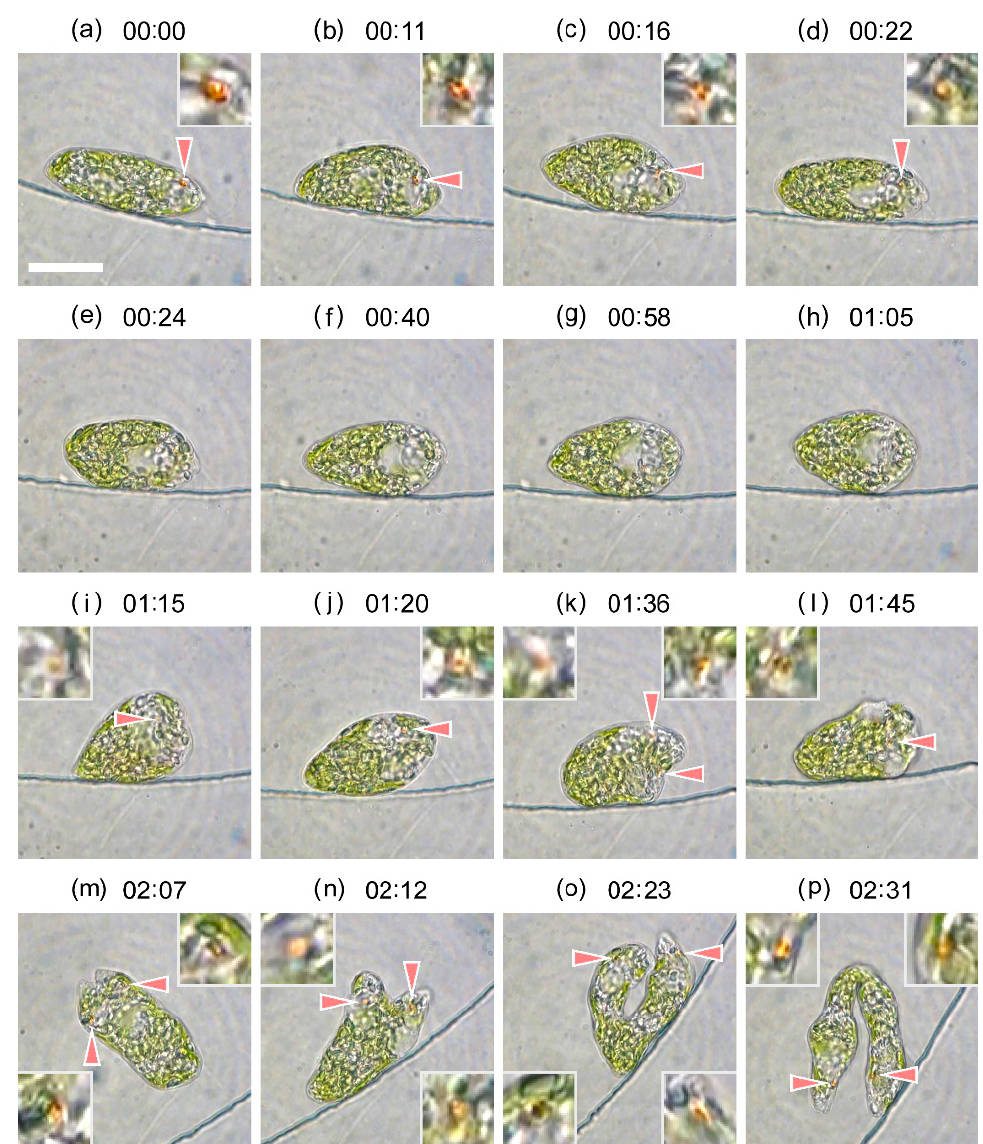
Figure 7. Images extracted from the video recording of the experiment depicted in Figure S1. ( a ) 17.52 h, ( b ) 17.70 h, ( c ) 17.79 h, ( d ) 17.89 h, ( e ) 17.92 h, ( f ) 18.19 h, ( g ) 18.49 h, ( h ) 18.60 h, ( i ) 18.77 h, ( j ) 18.85 h, ( k ) 19.12 h, ( l ) 19.27 h, ( m ) 19.64 h, ( n ) 19.72 h, ( o ) 19.90 h, and ( p ) 20.04 h. Time index given in the figure is shifted as a reference; 00:00 (hh:mm) corresponds to 17.52 h in Figure S1. The eyespot indicated by arrow is enlarged by four times in the inset. Scale bar, 20 µ m. Dynamic evolution of cell division is provided in the supplementary movie S4.